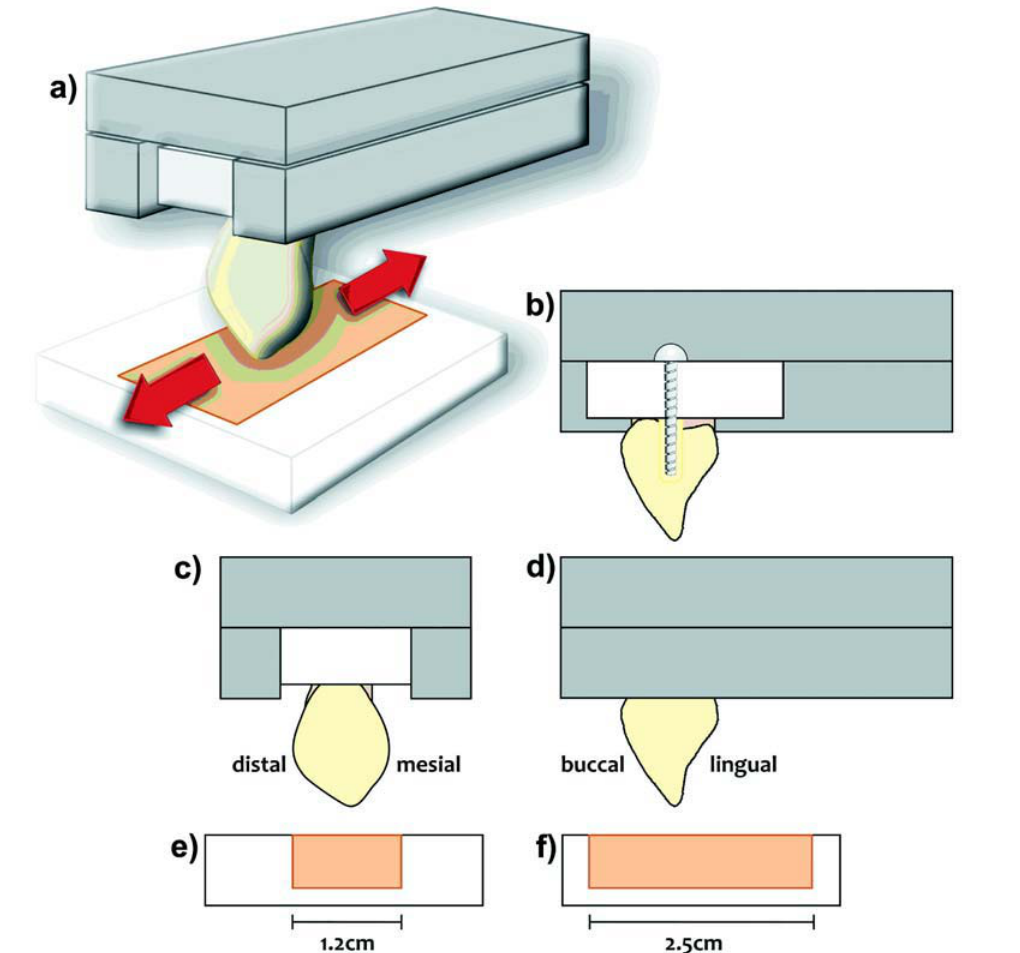
FIGURE 1- a) The canine tooth specimen mounted on the upper stainless steel holder of the apparatus (movable part) and the antagonist plate mounted on the fixed bottom part. b) The canine specimen fixed on the top of a tooth brush using a screw and composite resin (internal aspect). c,d) The shape of the canine specimen (frontal and lateral aspect). e, f)